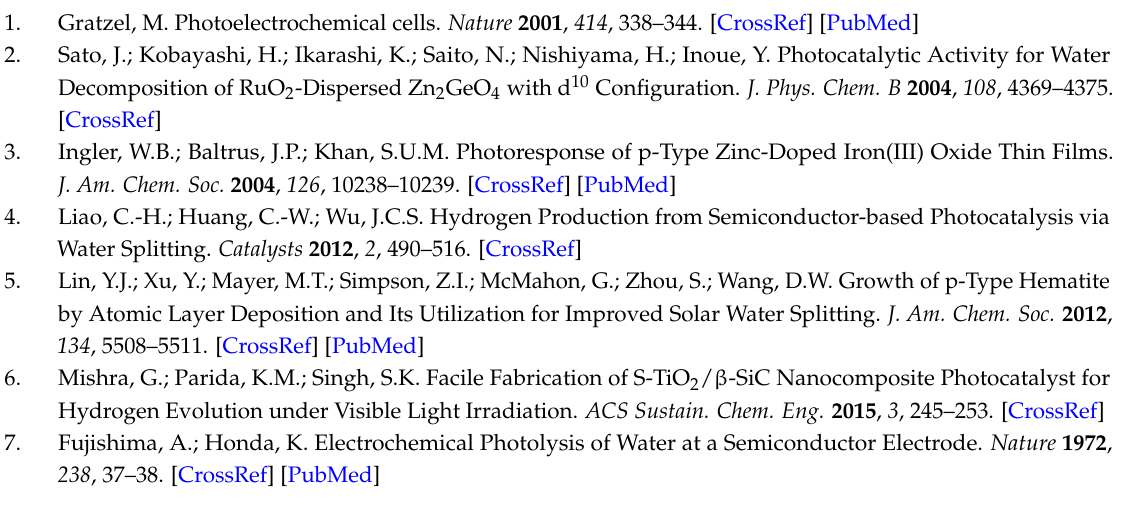
Figure S1: XPS (X-ray photoelectron spectroscopy) spectrum of the S 2p regions for the WS 2 -1/TiSi 2 -723 sample. (The blue lines: the deconvolved peaks for S 2p3/2 and S 2p1/2 of WS 2 -1/TiSi2-723; the red line: the fitted result of the blue lines.). Figure S2: Photoluminescence spectra of TiSi 2 and WS 2 -1/TiSi 2 -723. Excited wavelength: 532